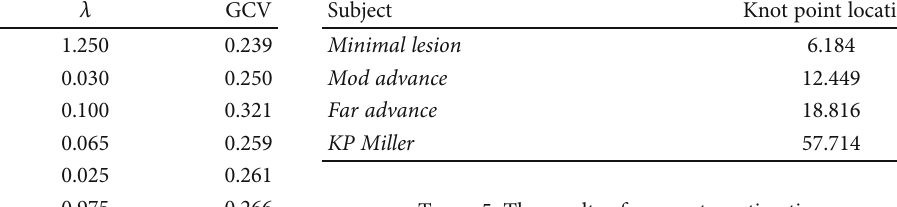
Table 5: The results of parameter